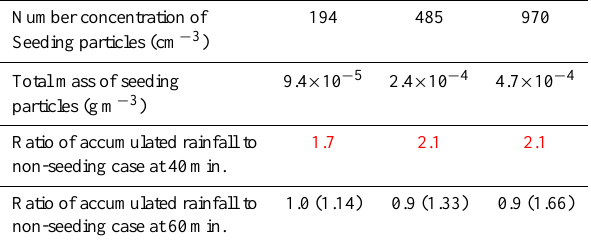
Table 7. Ratios of seeded-case to non-seeded-case accumulated sur- face rainfall averaged over the domain at 40 and 60min. Seeding of shallow convective cloud is carried out with flare particles (up to 25µm in radius). A ratio indicating an increase is colored red. Ratios of seeded-case to non-seeded-case (665cm − 3 ) cloud droplet number concentrations at 50m above the base of the cloud center at 11.5min are shown in parentheses.